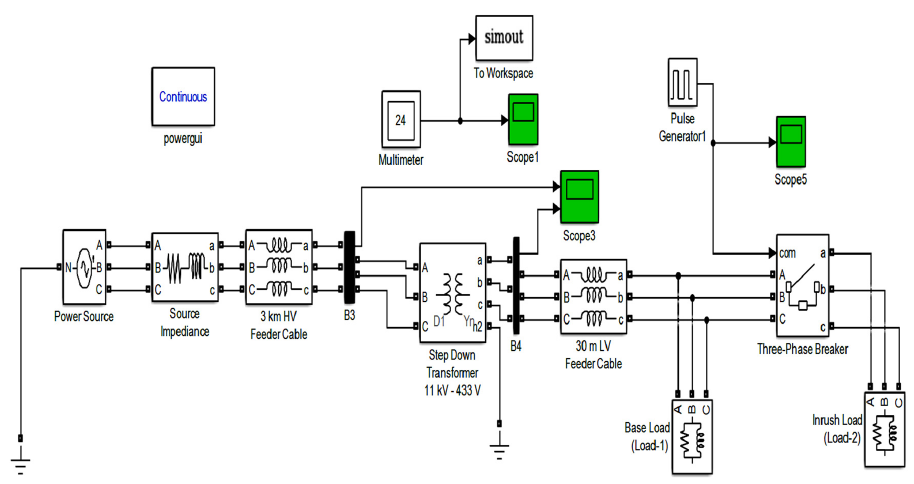
Figure 13. Simulink block diagram for a three phase power supply system.